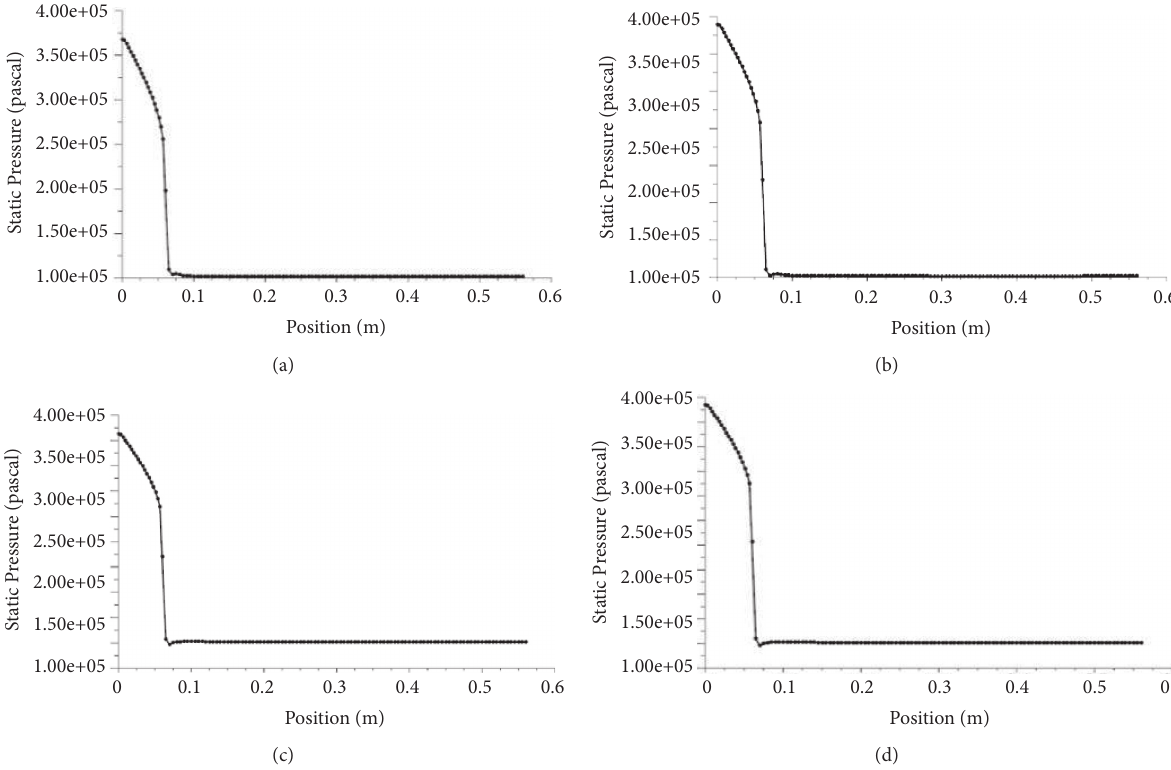
Figure 4: The results of gas pressure distribution along the axis with different blasting pressures. (a) The gas pressure distribution along the axis with the blasting pressure of 0.5 MPa. (b) The gas pressure distribution along the axis with the blasting pressure of 0.6MPa. (c) The gas pressure distribution along the axis with the blasting pressure of 0.7MPa. (d) The gas pressure distribution along the axis with the blasting pressure of 0.8